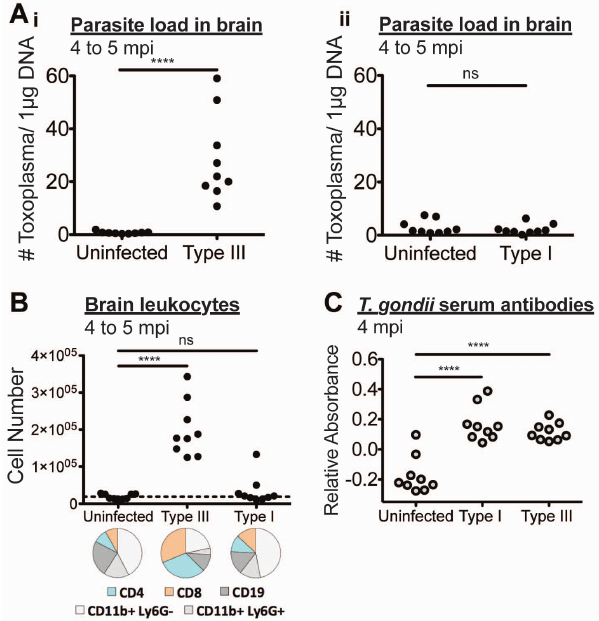
Figure 2. Persistent inflammation during chronic infection with Type III but not Type I parasites. [A] Quantitative PCR of genomic DNA prepared from 10% of brain homogenate reveals that parasite DNA was readily detectable in Type III-infected animals (i) but undetectable in attenuated Type I-infected animals (ii). [B] Brain leukocytes were percoll purified from the remaining brain and meningeal homogenate, stained for surface markers CD4, CD8, CD19, CD11b, and Ly6G, and assayed using flow cytometry. Total numbers